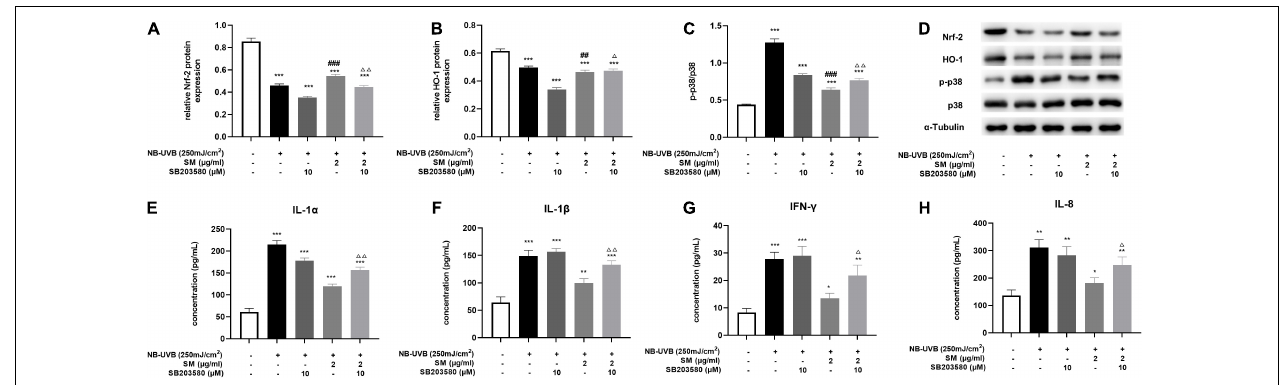
FIGURE 4 | Solamargine (SM) exerting anti-inflammatory effect via the activation of p38 MAPK/Nrf2/HO-1 signaling pathways in HaCaT cells. After UVB irradiation of HaCaT cells, the protein level of Nrf-2 (A) and HO-1 (B) was significantly decreased, and p-p38/p38 (C) expression was significantly increased. This effect can be reversed by SM. The expression of Nrf-2 and HO-1 proteins in HaCaT cells was significantly decreased and p-p38/p38 expression was significantly increased in the UVB + SM + p38 inhibitor (SB203580) group compared with the UVB + SM group. After the addition of the p38 inhibitor, IL-1 α (D) Western blot assay of Nrf-2, HO-1, p-p38 and p38 after UVB exposure with/without SM or SB203580 treatment. (E) , IL-1 β (F) , IL-8 (G) , and IFN- γ (H) in the cell supernatant were significantly increased. The data represent the mean ± S.D. from three independent experiments. * P < 0.05, ** P < 0.01, *** P < 0.001 (vs. non-treated group); (cid:49) P < 0.05, (cid:49)(cid:49) P < 0.01 (vs. NB-UVB irradiated group); ## P < 0.01, ### P < 0.001 (vs. NB-UVB irradiated and SM treated